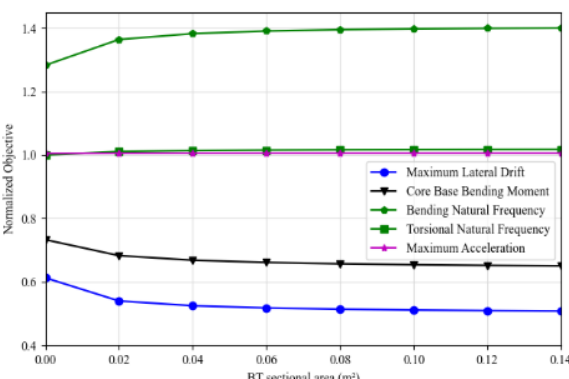
Figure 6. Influence of the BT area in relation to the objectives/criteria analyzed.